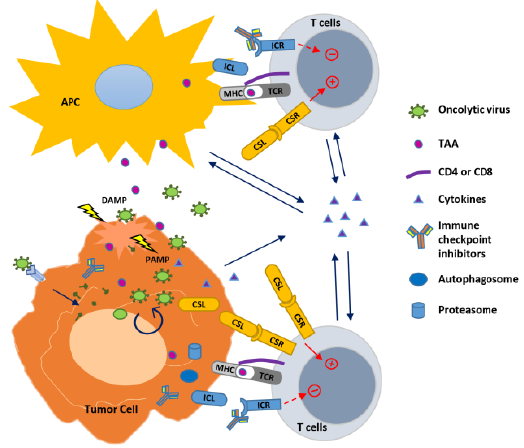
Figure 1. Strategies to improve oncolytic virus-mediated anti-tumor immunity. Oncolytic viruses (OVs) infect and replicate inside cancer cells, resulting in cell lysis and propagation of virions to infect nearby cancer cells. This process generates pathogen-associated molecular patterns